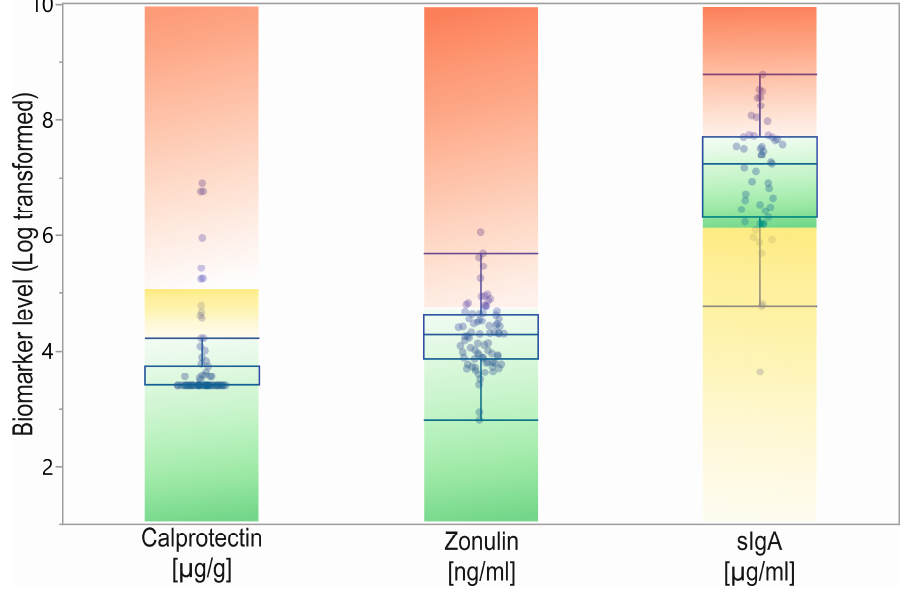
Figure 2. The calprotectin, zonulin, and sIgA data from patients with reference range. Designation: green—normal level; yellow—subnormal or gray-zone; red—elevated level.